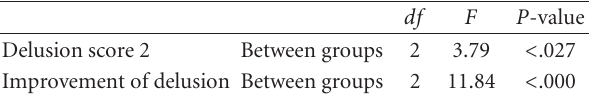
Table 1: ANOVA for delusion score and improvement of delusion scores at second interview.